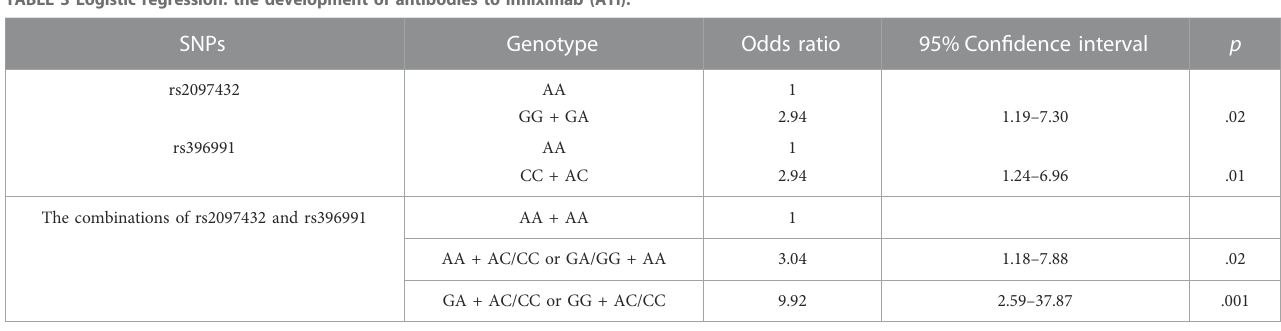
TABLE 3 Logistic regression: the development of antibodies to in fl iximab